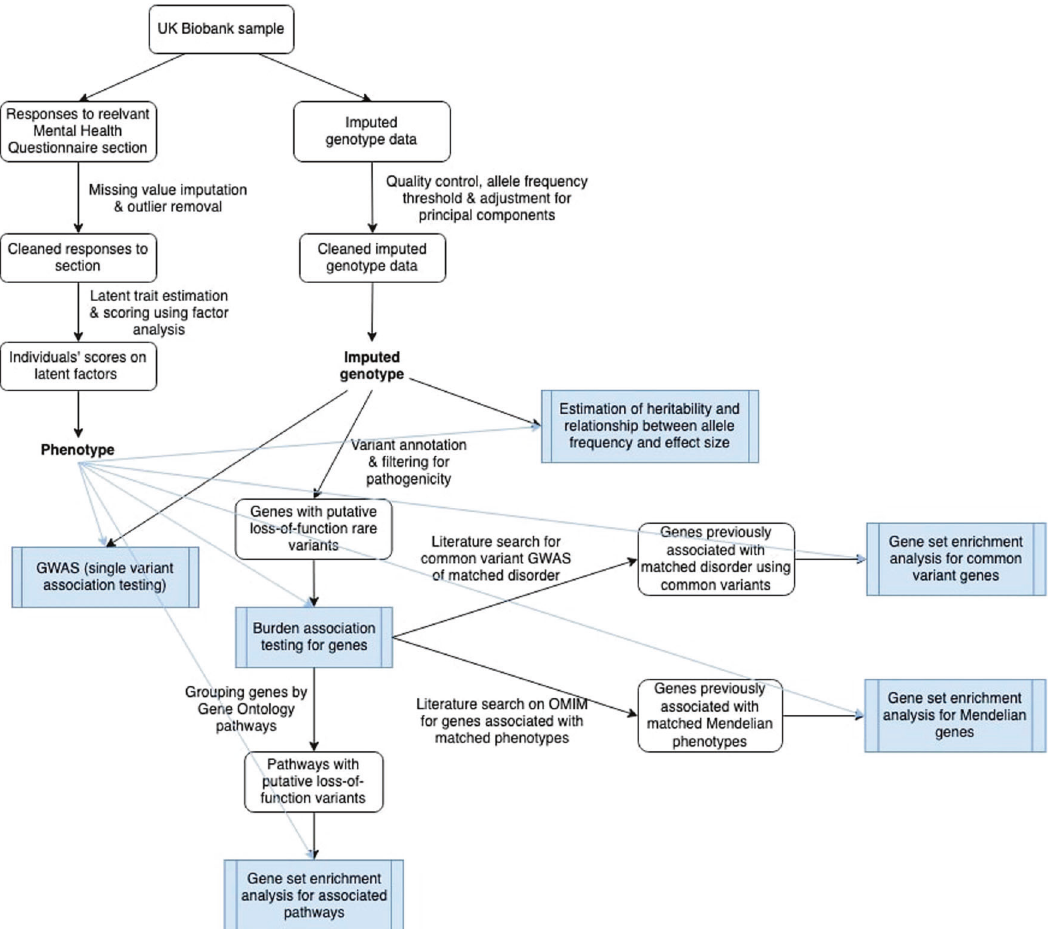
Fig. 1 Flowchart depicting methods used in this paper. Shaded boxes represent statistical analyses reported in the results of this paper.